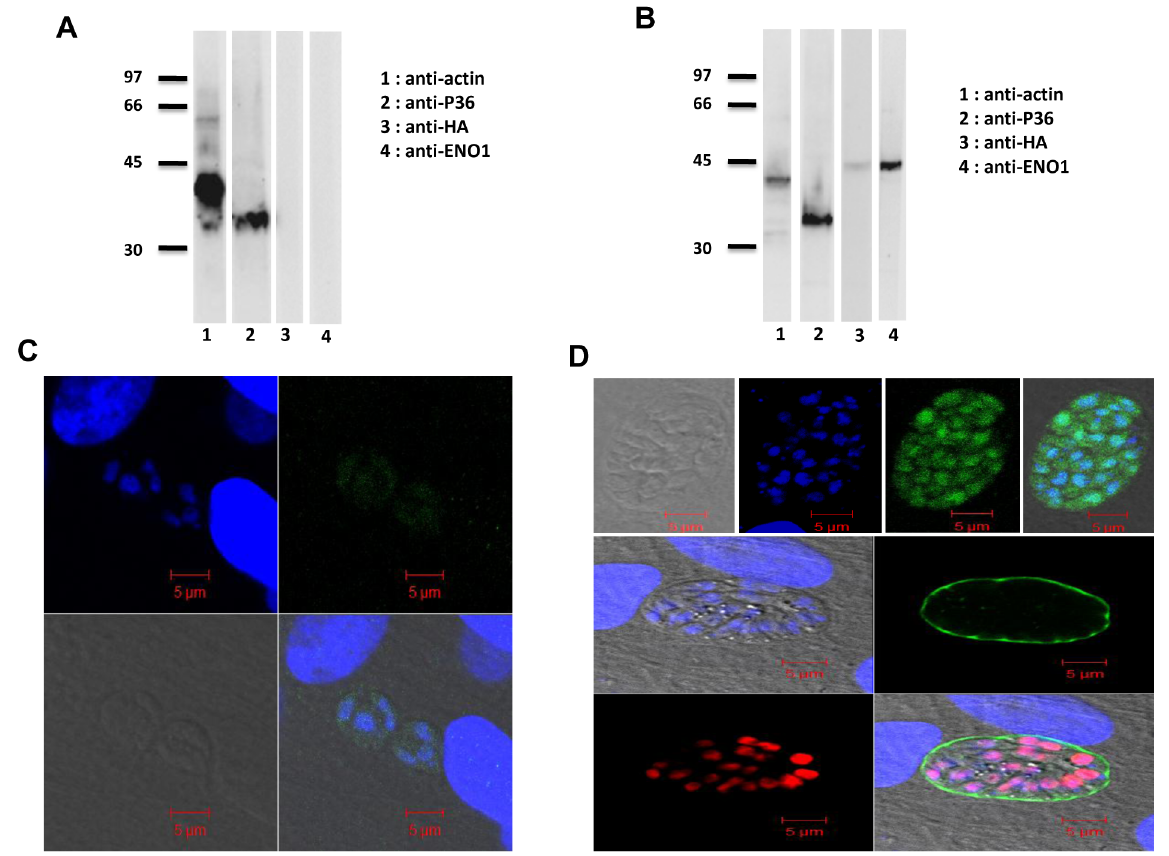
Figure 8. Complementation of Pru D ku80 D Tgeno1 mutants by ectopic expression of TgENO1-HA and growth under bradyzoite culture conditions. A) Western blot analysis of Pru D ku80 D Tgeno1 mutants using total SDS-extracted antigens from in vitro -induced intracellular bradyzoites and probed with monoclonal antibodies specific to T. gondii actin (lane 1), bradyzoite-specific major surface protein 1 (anti-P36, lane 2), the influenza hemagglutinin (HA)-tag (anti-HA, lane 3) and TgENO1 (lane 4). B) Western blot analysis of complemented Pru D ku80 D Tgeno1 mutants using total SDS-extracted antigens from in vitro -induced intracellular bradyzoites and probed with monoclonal antibodies specific to T. gondii actin (lane 1), bradyzoite-specific major surface protein (anti-P36, lane 2), the influenza hemagglutinin (HA)-tag (anti-HA, lane 3) and TgENO1 (lane 4). C) Confocal microscopy of in vitro -induced intracellular bradyzoites of Pru D ku80 D Tgeno1 mutants that were grown in confluent HFF cells and stained with polyclonal anti-HA antibodies. The panels show nuclei stained with DAPI (upper left panel), IFA (upper right panel), phase contrast (lower left panel), and merged images (lower right panel). Scale bars are 5 m m. D) Confocal microscopy of in vitro -induced intracellular bradyzoites of complemented Pru D ku80 D Tgeno1 mutants that were grown in confluent HFF cells and stained with anti-HA antibodies (upper panels show phase contrast, DAPI, IFA, and merged images). Complemented Pru D ku80 D Tgeno1 mutants were grown in confluent HFF cells before double staining with FITC-labeled dolichol biflorus lectin (cyst wall marker, green) and polyclonal anti-HA antibodies (red). The nuclei were stained by DAPI (left middle panel, blue). IFA reveals staining of the cyst wall (right middle panel, green) and ectopic TgENO1-HA protein expressed in the complemented Pru D ku80 D Tgeno1 mutants was stained by anti-HA antibodies (lower left panel, red). Merged images are shown in the lower right panel. Scale bars are 5 m m.